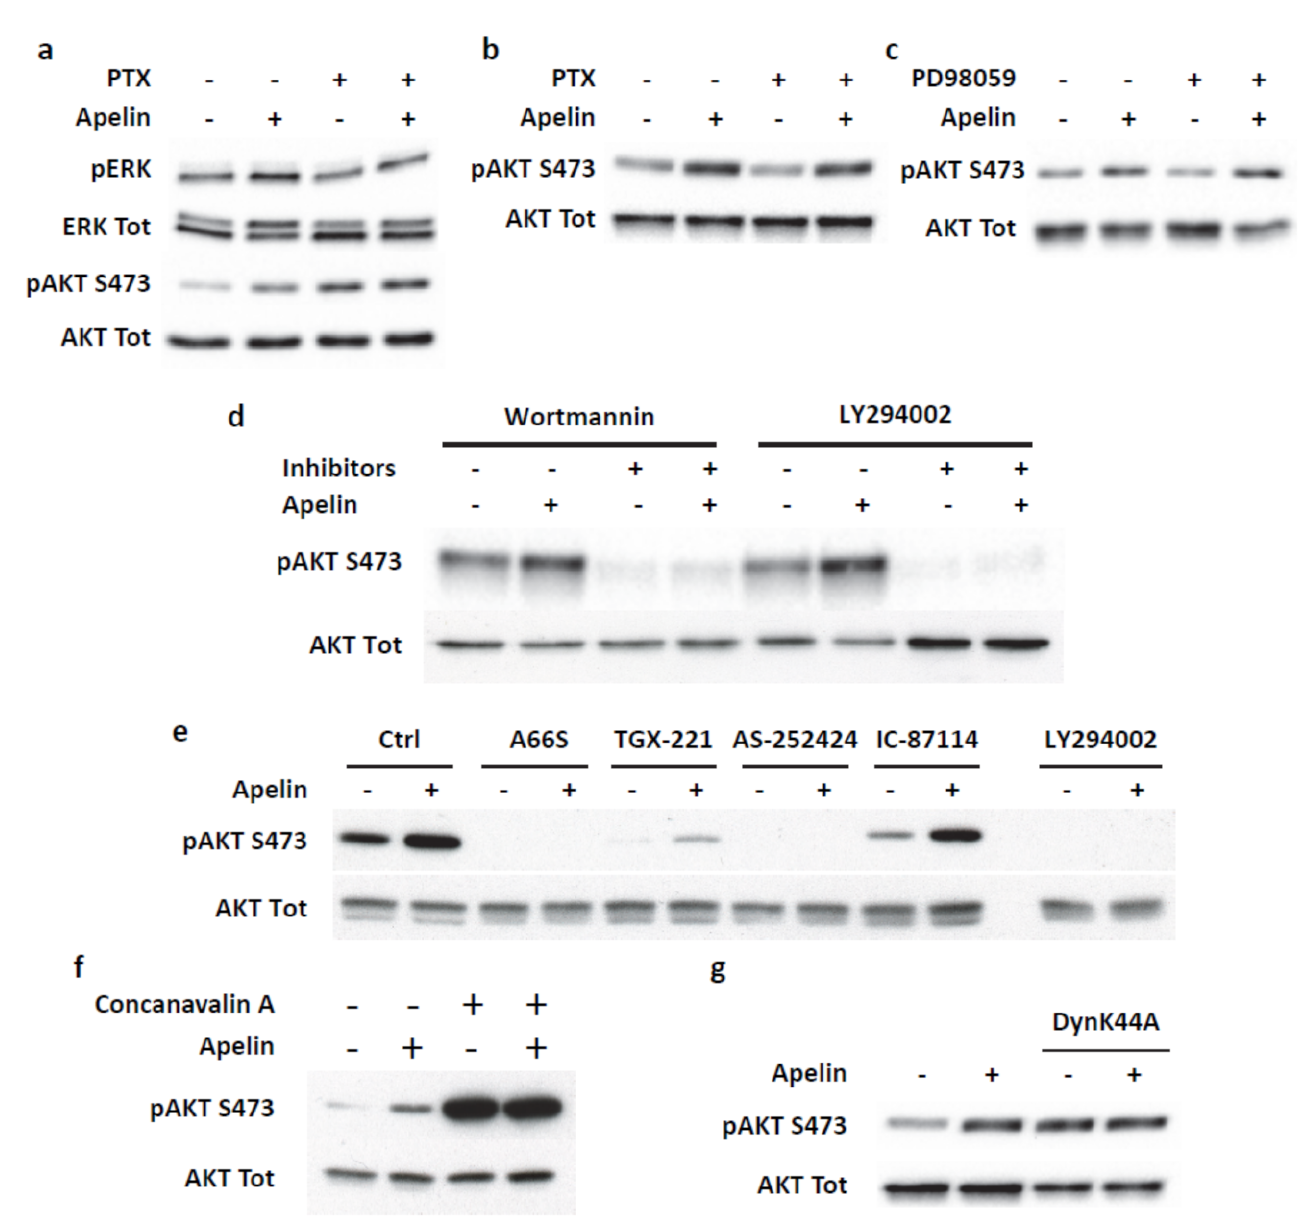
Figure 5. Transient ERK/MAPK stimulation by apelin is dependent on Gi/o proteins, whereas sustained Akt activation is G protein-independent but relies on PI3K α and APJ internalization. ( a ) Analysis of the signaling pathways involved in short-term ERK and Akt activation. MiaPaCa-2 cells were serum-starved and pretreated with pertussis toxin (100 ng/mL) for 20 h and stimulated with apelin 500 nM for 15 min. ( b – e ) Analysis of the signaling pathways involved in sustained Akt activation. MiaPaCa-2 cells were serum-starved and pretreated with pertussis toxin (100 ng/mL) for 20 h. ( b ), 1 h with either PD098059 (10 µ M) ( c ), Wortmannin (100 nM) and LY204002 (10 µ M) ( d ) or A66 (700 nM), TGX-221 (0.5 µ M), AS-252424 (100 nM), IC-87114 (10 µ M) ( e ), and then stimulated with apelin 500 nM for 3 h. ( f , g ) APJ internalization by apelin is a prerequisite to induce Akt activation. MiaPaCa-2 cells were starved of serum for 20 h and pretreated with ( f ) Concanavalin A (100 µ g/mL) for 30 min. or transiently transfected with dominant negative K44A mutant of Dynamin ( g ) and stimulated with apelin for 3 h. Representative Western blot from n =